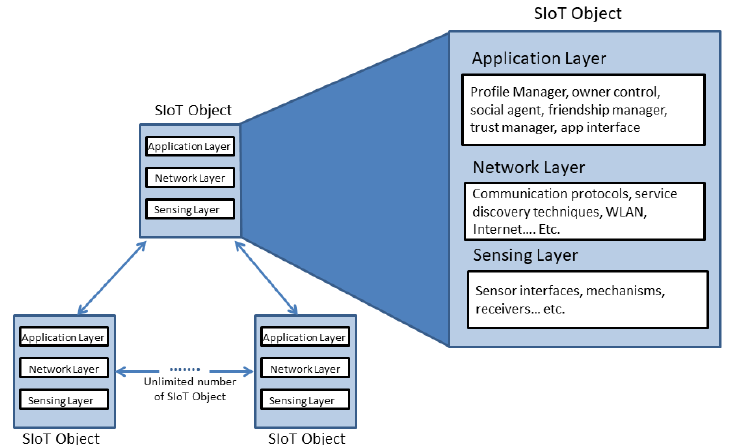
Figure 5. Proposed architecture.